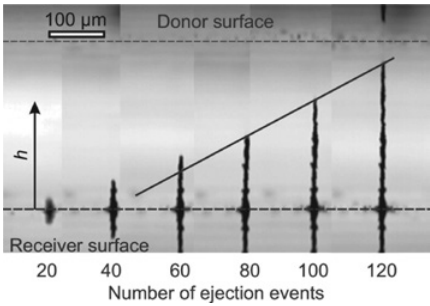
Figure 11: Snapshots of a pillar as a function of the number of